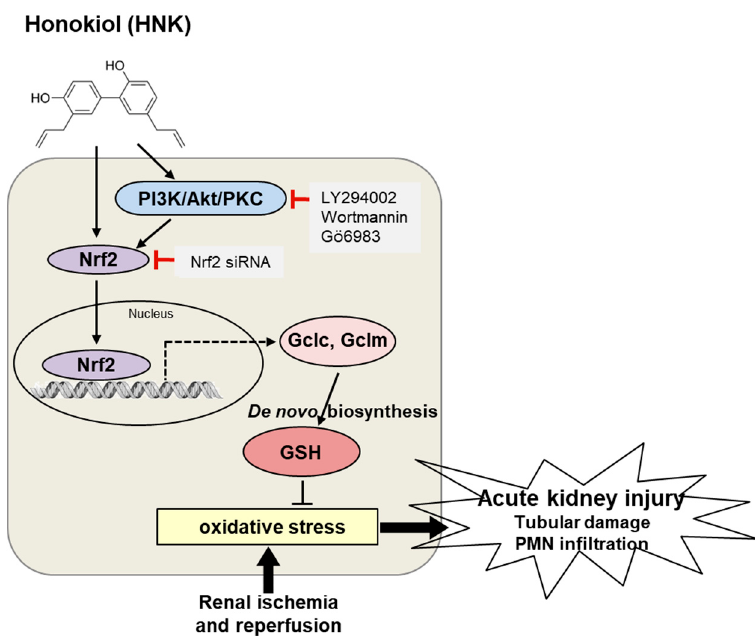
Figure 8. A proposed molecular mechanism of honokiol that protects the kidney against renal IR injury. Honokiol activates PI3K/Akt and PKC signaling, increasing nuclear translocation of Nrf2 for transcription of antioxidant genes including Gclc and Gclm. An increase of GSH exerts an antioxidant effect, attenuating IR injury. Solid, dashed, and bold arrows indicate signaling transduction pathways, gene transcription, and induced pathology, respectively. Different colors represent individual pathways or proteins.